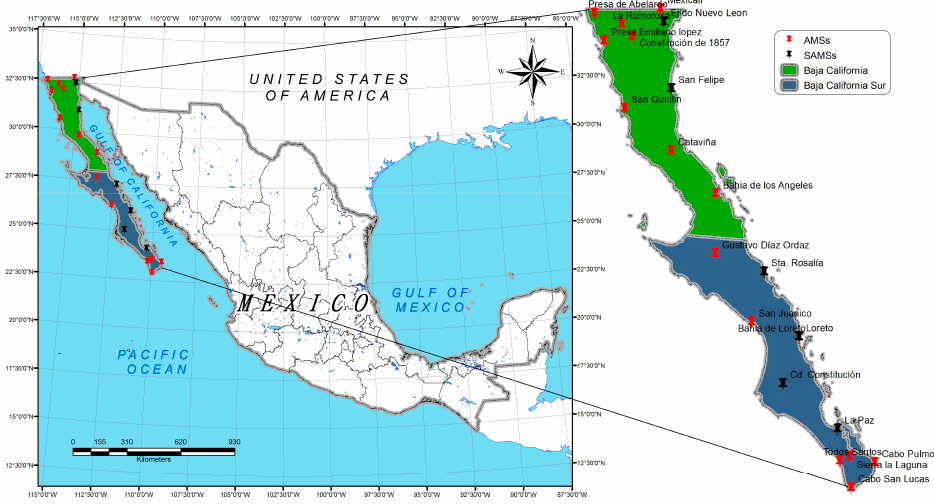
Figure 2. Geographic position of AMSs and SAMSs on the Baja California Peninsula, Mexico.